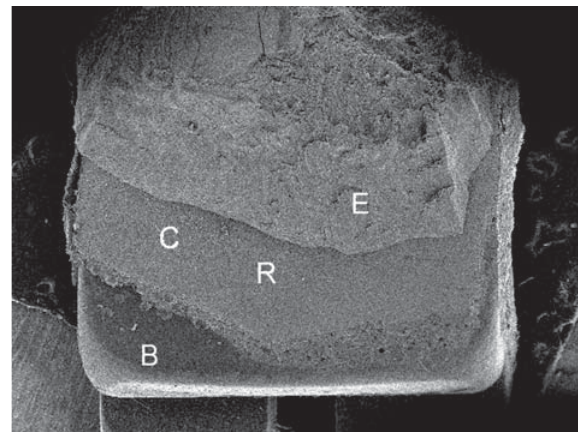
Figure 2- Scanning electron microscopy images in SE (cid:18)(cid:15)"(cid:23)(cid:10) (cid:28)(cid:22)(cid:10) (cid:11)(cid:12)(cid:3)(cid:3)(cid:3)?(cid:10) (cid:18)(cid:28)$!(cid:21)&(cid:17)(cid:28)(cid:22)(cid:21)(cid:15)!(cid:10) (cid:20)E(cid:15)H(cid:21)!$(cid:10) W(cid:30)(cid:28)(cid:17)<(cid:23)(cid:22)(cid:20)(cid:10) H(cid:21)(cid:22)E(cid:10) mixed failure for Gh-TC with >50% of resin composite on the bracket (adhesive remnant index - ARI=1) associated with enamel fracture. The bracket (B), composite (C), enamel (E) and spot of roughness evaluated (R) are showed on the